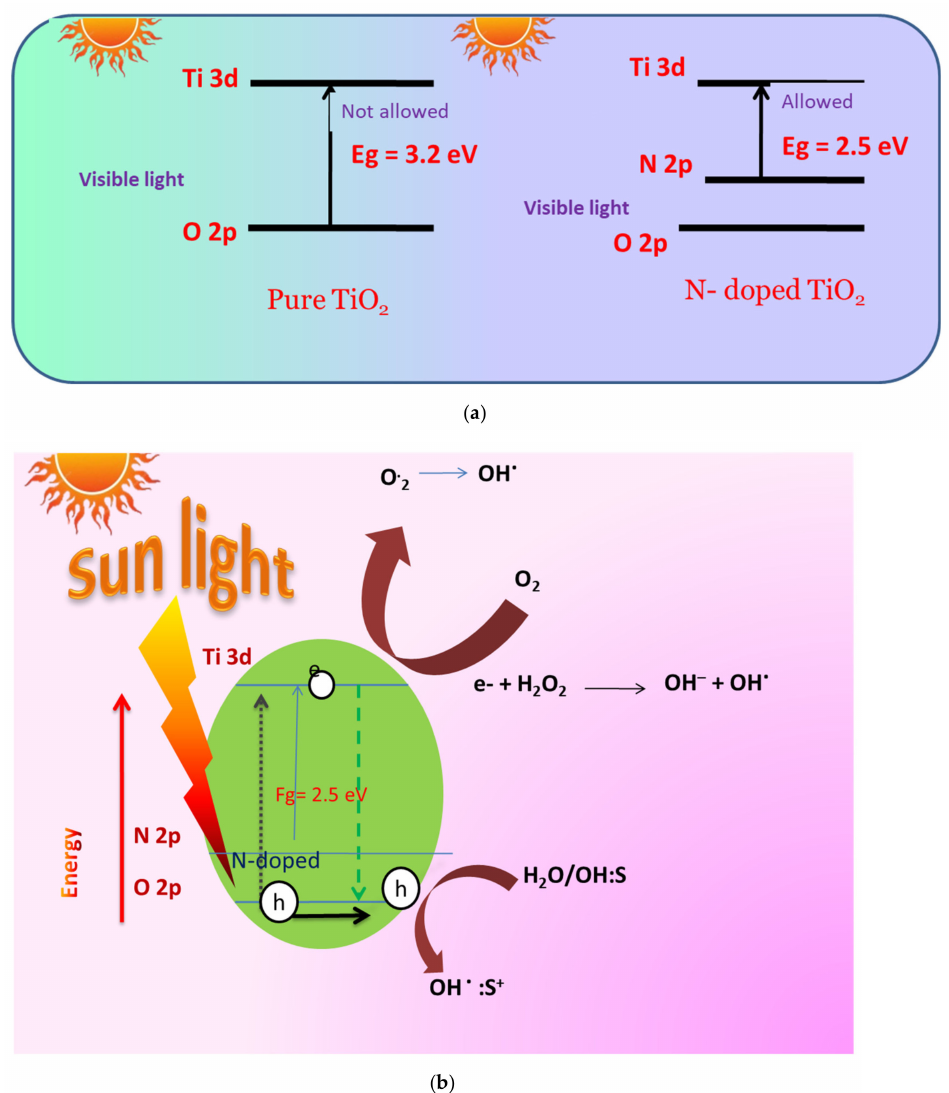
Figure 6. Schematic representation of the energy level diagrams of bare TiO 2 and N-doped TiO 2 ( a ) and reaction mechanism of the degradation of organic dyes/pathogens in the presence of N-doped TiO 2 ( b